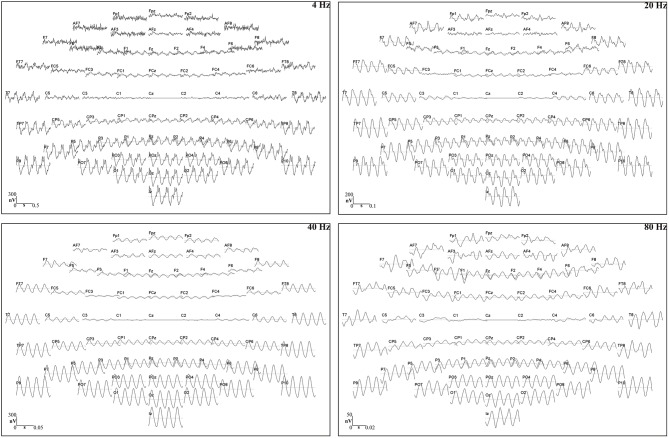
Auditory evoked potentials topographic maps. The evoked potentials are referenced to the vertex electrode (Cz) and represent the time-domain grand mean averaged response to four cycles of the 4, 20, 40, or 80 Hz modulated noise. The 4, 20, 40, and 80 Hz grand mean response period is obtained by averaging 256 artifact-free epochs from all participants (N = 53) for the three sides of stimulation (L, R, BI). The waveforms are plotted at the approximate electrode locations viewed from the top of the head with the nose at the top of the figure.